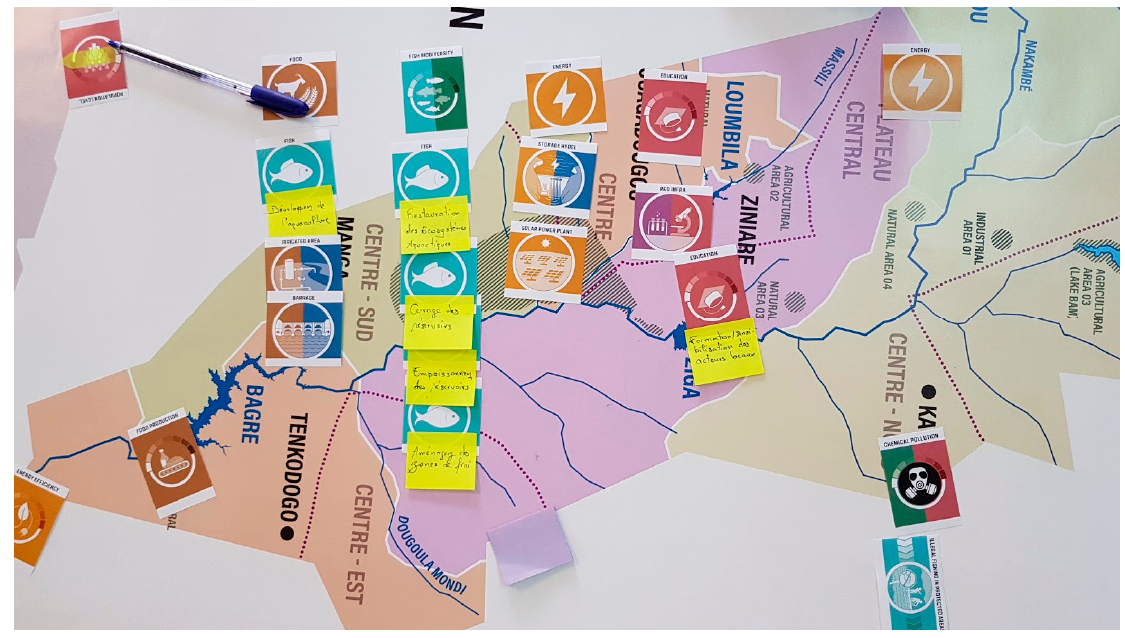
Figure A2. Representation by the participants to the strategic simulations of the future pathways regarding the vision-priority focus on economy and energy sectors in Nakambe Basin.